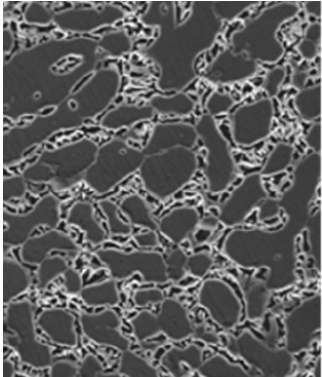
Figure 29: Duplex heat-treated.